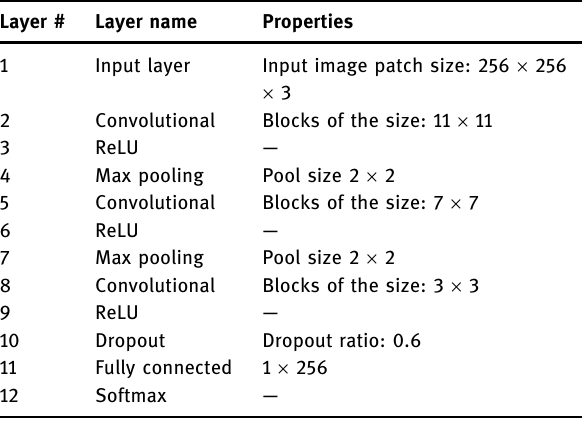
Table 1: Architecture of the suggested